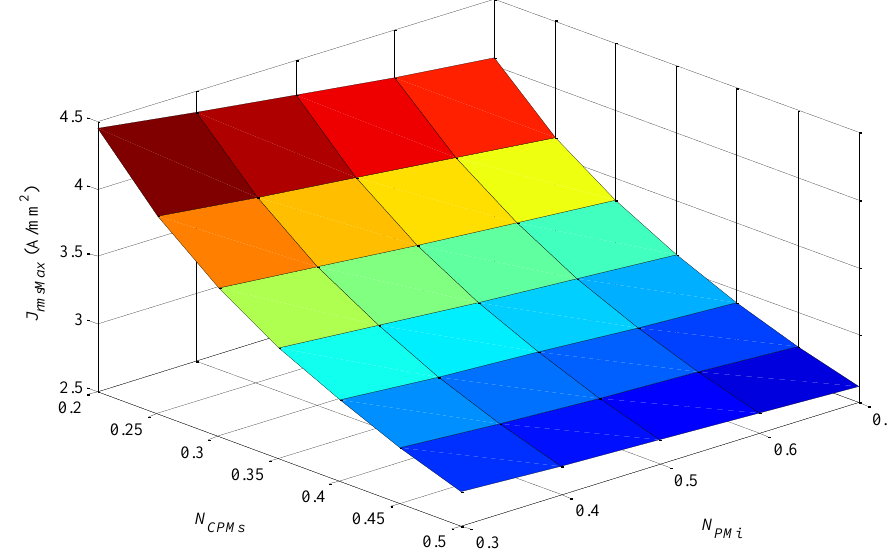
Figure 11. Maximum effective current density applicable at the windings in order to reach the maximum allowable temperature of 80 °C at the windings as a function of the parametric variables N CPMs and N PMi .